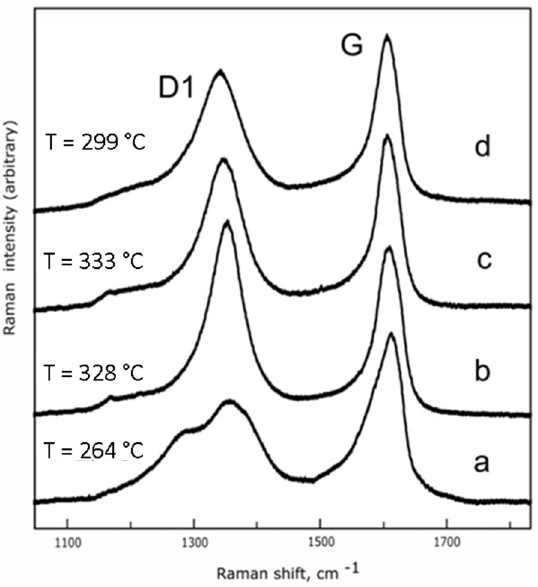
Figure 8. Representative Raman spectra of carbonaceous matter from concentrically zoning ( a ), spherulitic ( b ), and moss ( c ) agates, and inter-pillow matrix ( d ). Calculated metamorphic tempera- tures refer to the average value (calculated on the basis of 26 measurements for ( a ), 11 for ( b ), 10 for ( c ), and 28 for ( d